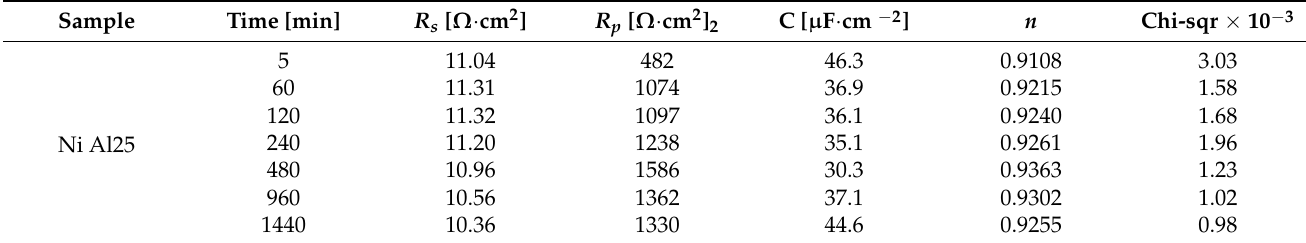
Table 3. Parameters obtained in fitting the EIS diagrams shown in Figure